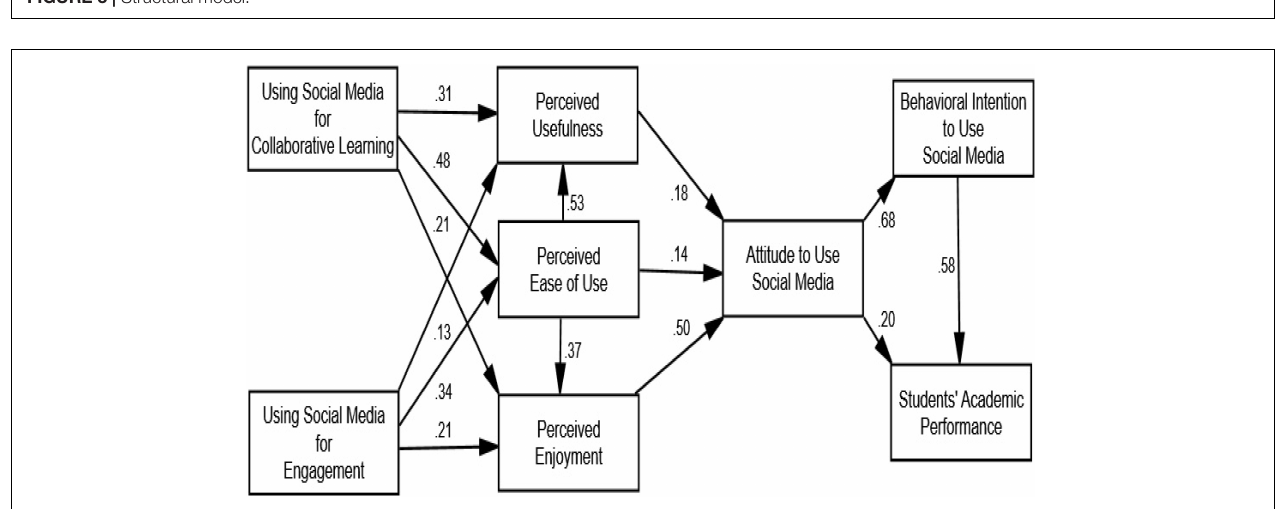
FIGURE 3 | Structural model.